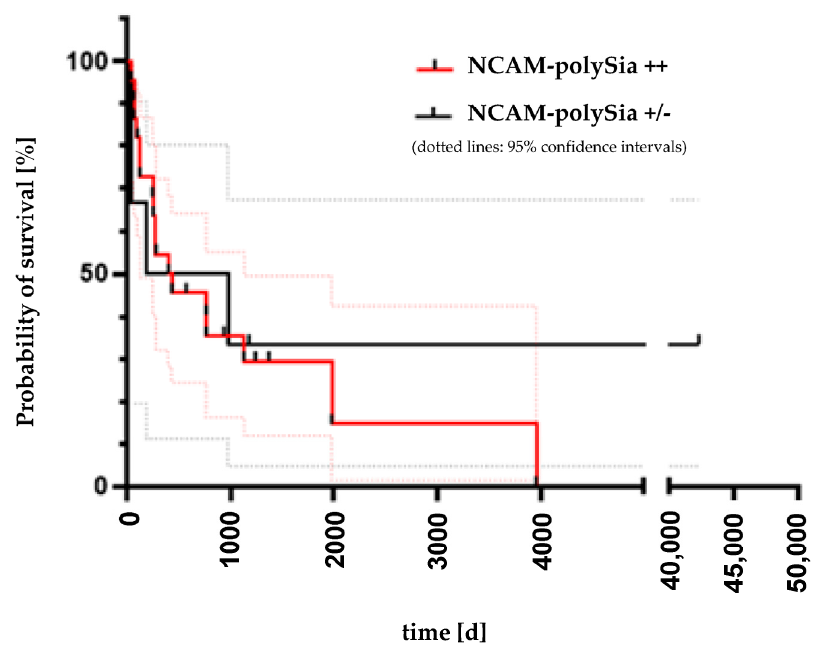
Figure 6. Kaplan-Meier progression-free survival analysis. The black curve shows the progression- free survival of the complete cohort. In the patient group with strong polySia-NCAM expression (red curve), progressive disease (abbr. PD) occurred in five patients. Another 12 patients died from disease. The median time to progressive disease (abbr. PD) or death was 395 days. The patient group with weak or no polySia-NCAM expression (green curve) was underrepresented with four patients. The median survival time was 21,164.5 days. This high number is because the two patients could be followed up for a very long time. With a p -value of 0.4198, the log-rank test revealed no significant difference between the two curves according to polySia-NCAM expression.